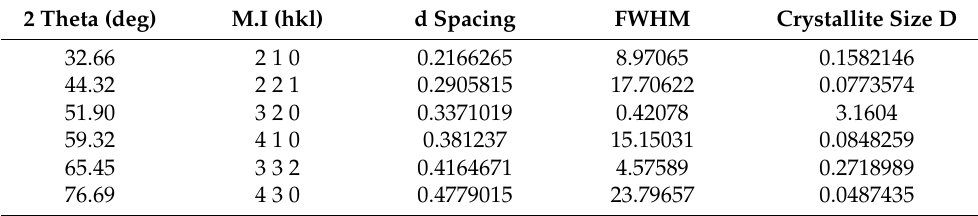
Table 3. XRD Diffraction Pattern of Fe-Mn BNPs.